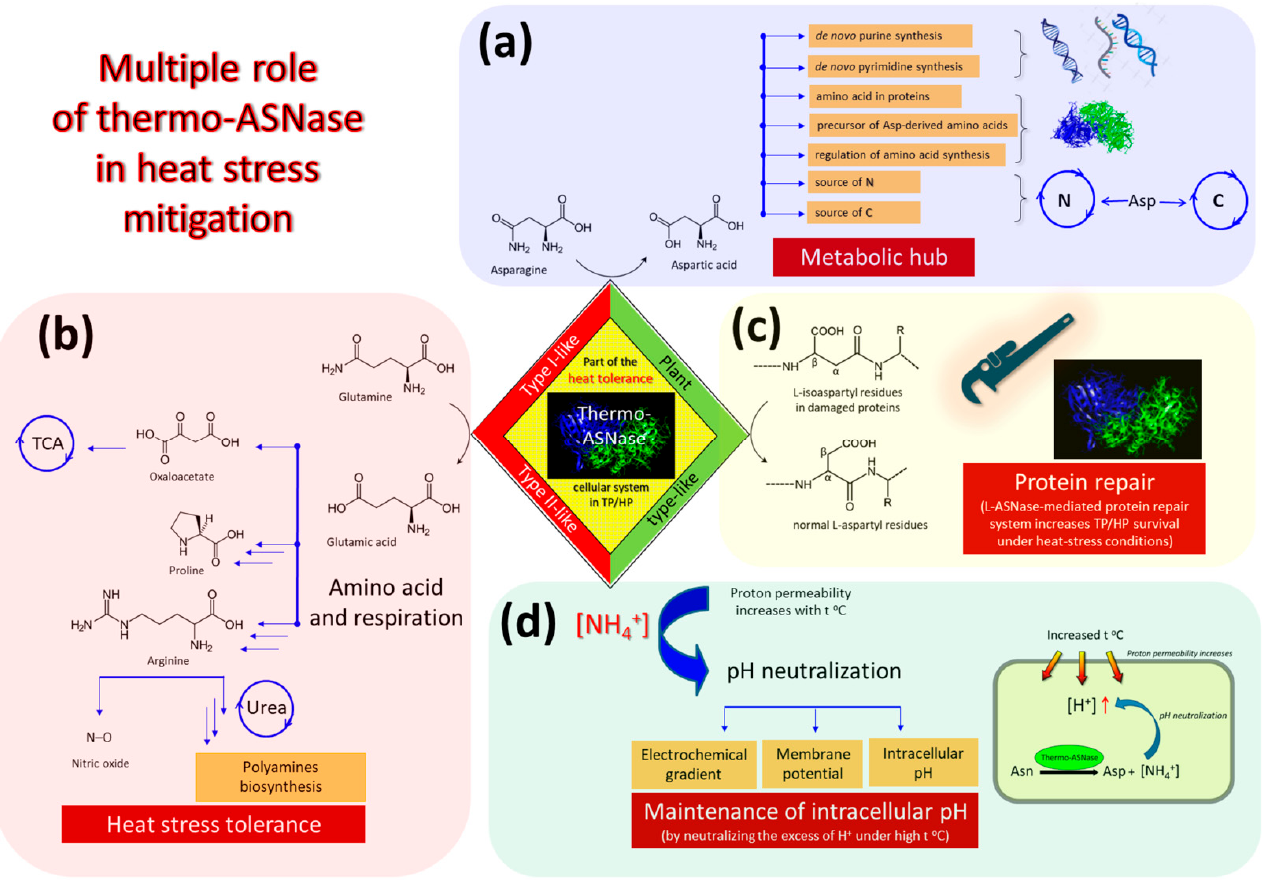
Figure 3. Proposed scheme of multiple effects of thermo-ASNases on the survival of thermophilic (TP) and hyperthermophilic (HP) microorganisms under heat stress. (TP) and hyperthermophilic (HP) microorganisms under heat stress. Asp-derived—aspartate-derived, N—nitrogen, C—carbon, TCA—tricarboxylic acid cycle. ( a ) Aspartic acid, formed from